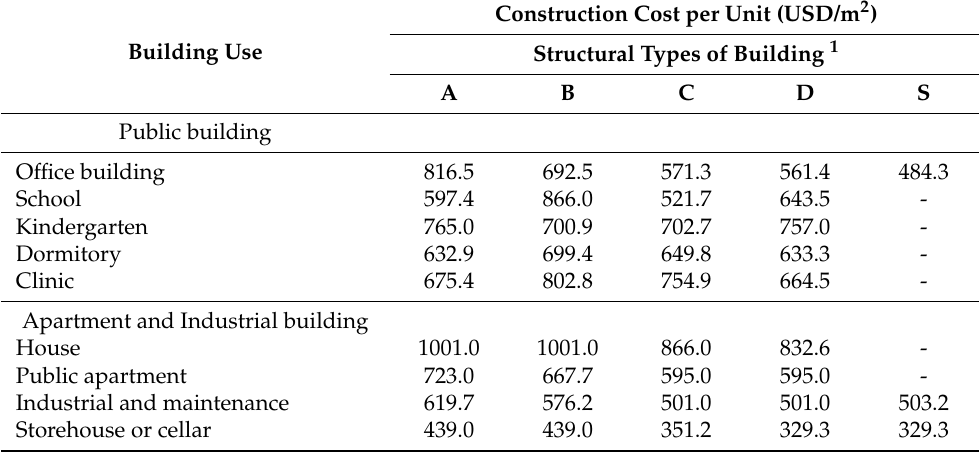
Table 7. Construction cost per unit for typical building uses and structural types.